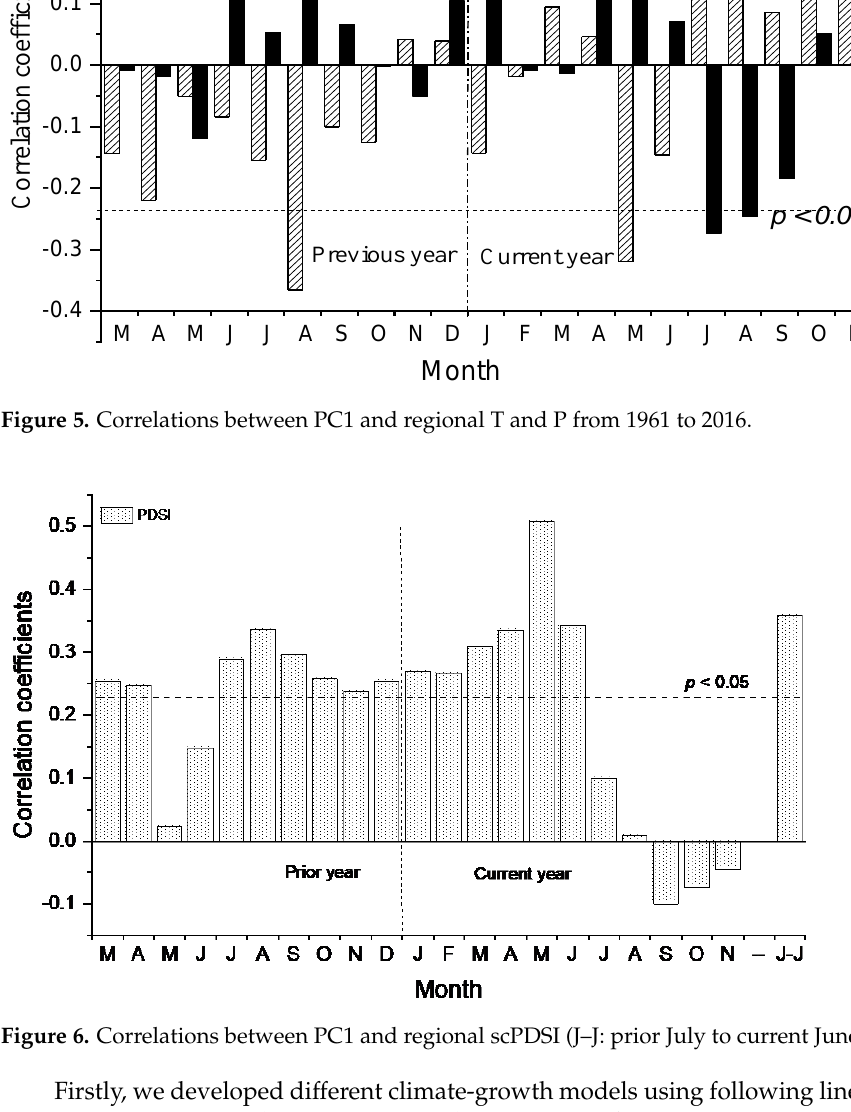
Figure 5. Correlations between PC1 and regional T and P from 1961 to 2016.